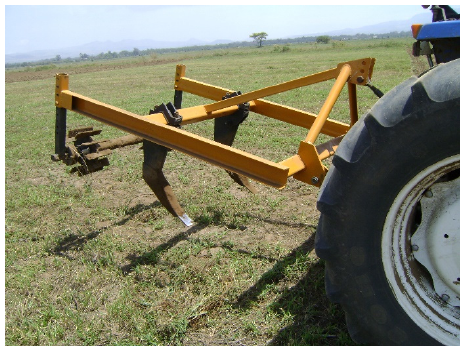
Figure 7. A tractor ‐ mounted chisel ‐ tined ripper which can be used to create narrow tilled strips for Figure 7. A tractor-mounted chisel-tined ripper which can be used to create narrow tilled strips for crop establishment. crop establishment.